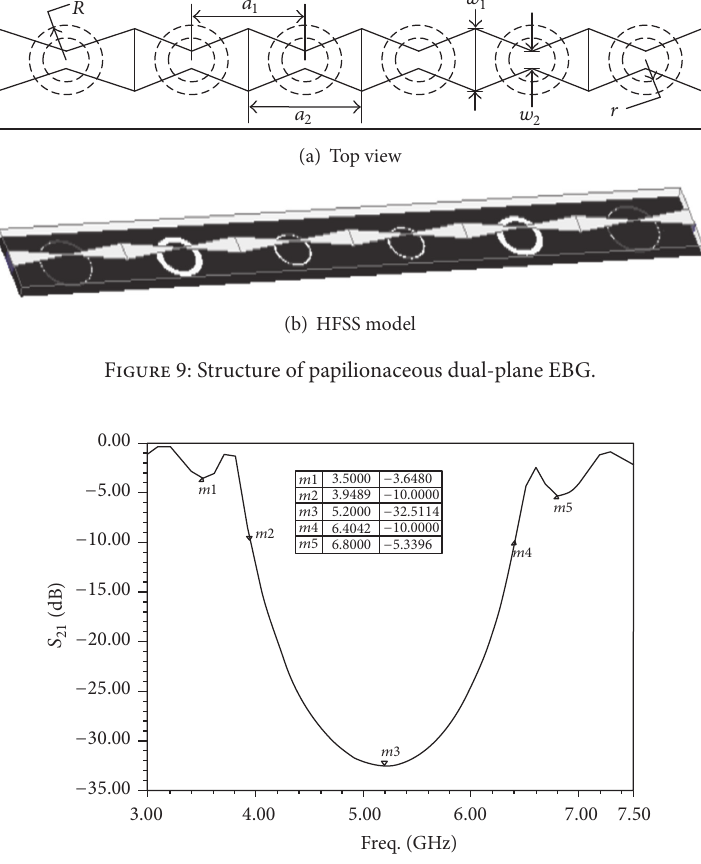
Figure 10: Simulated 𝑆 21 parameter of papilionaceous dual-plane EBG.